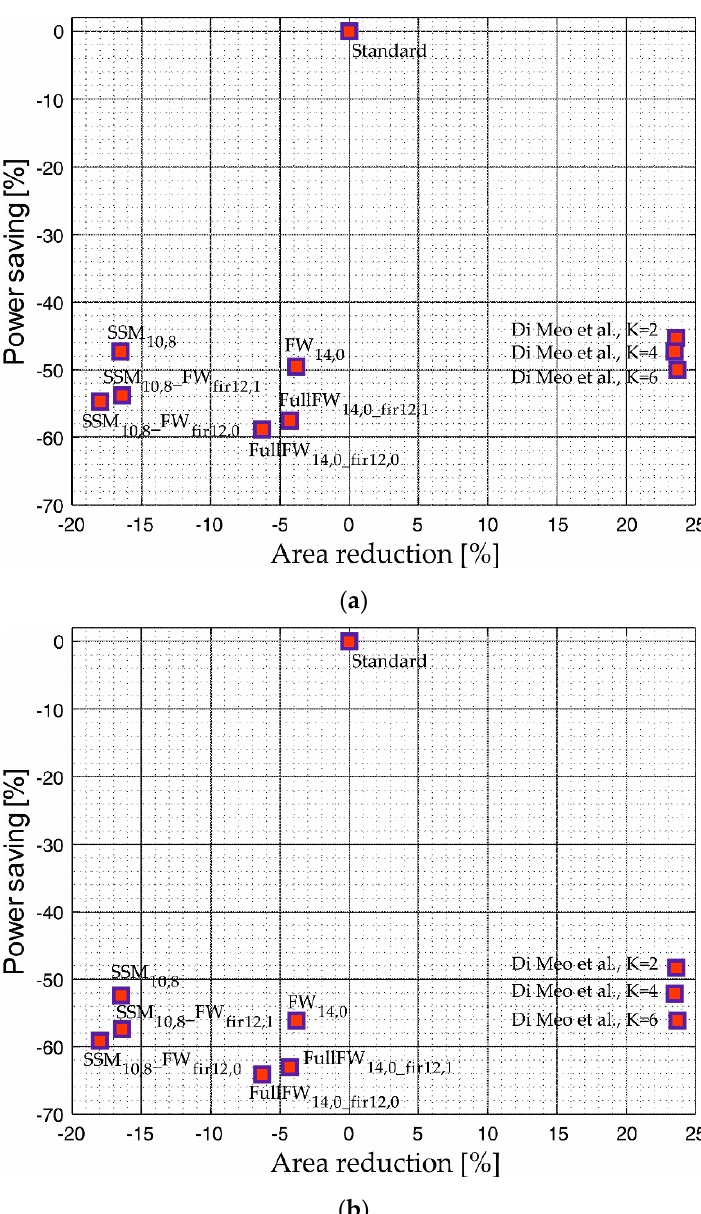
Figure 14. Plot of the hardware features in terms of power saving and area reduction for the imple- mentations with comparable regime MSE in the case of ( a ) FIR identification (MSE in the range − 85.9 dB/ − 86.2 dB) and ( b ) IIR identification (MSE in the range − 81.3 dB/ − 81.5 dB). The implementations by Di Meo et al. are related to the paper [41].